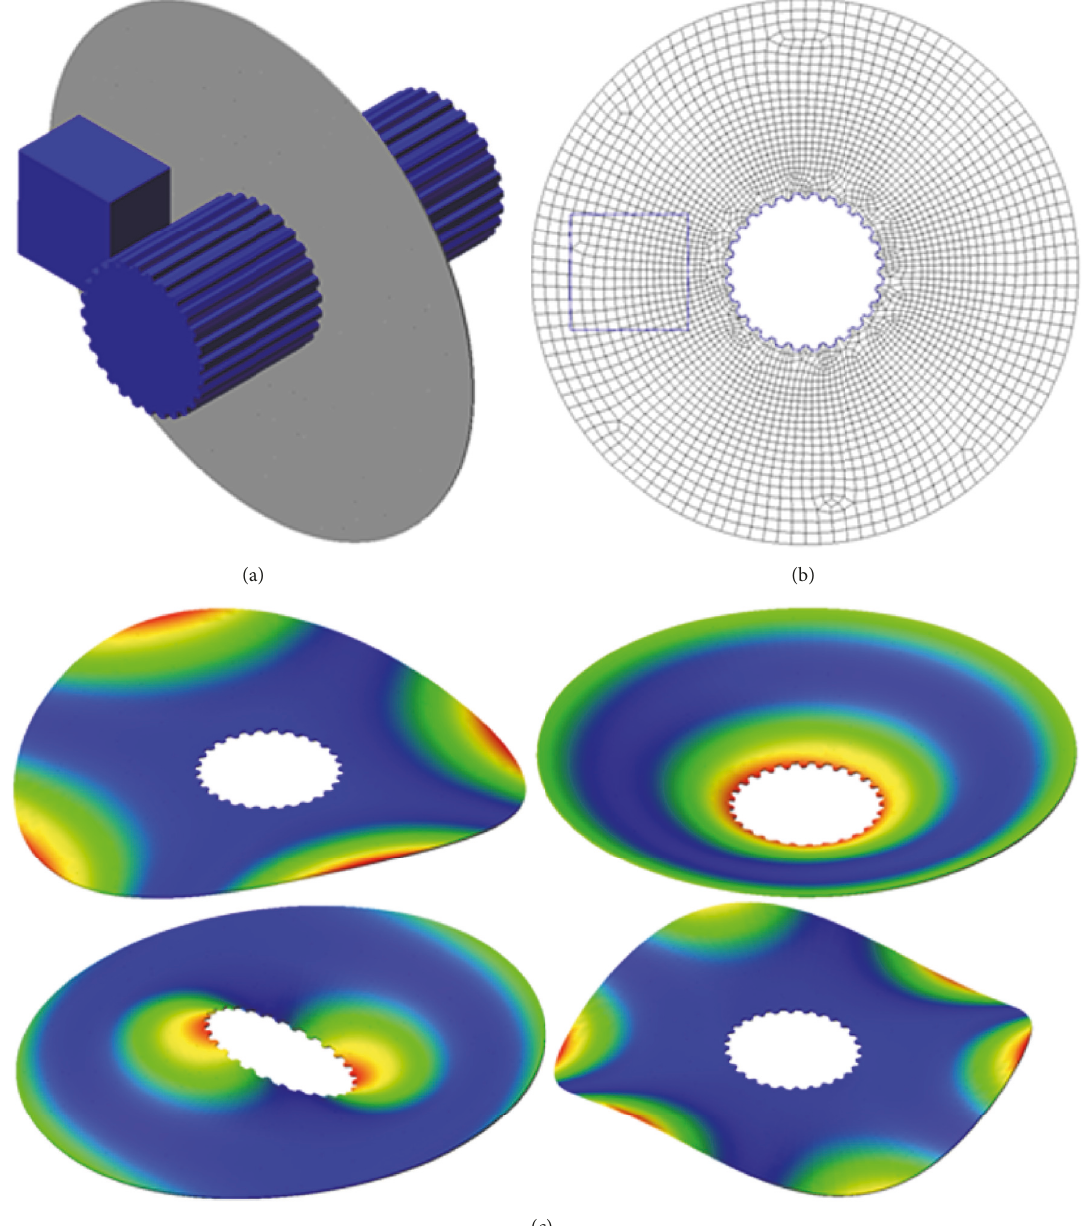
Figure 2: (a) Schematic of a multibody dynamics model of the guided saw, (b) FEM of the blade, and (c) the first 4 modes of a free blade: ( 0,2 ), ( 0,0 ), ( 1, 1 ), and ( 0, 3 ) modes with frequency of 27.7, 46.6, 69.1, and 103.5 Hz, respectively.